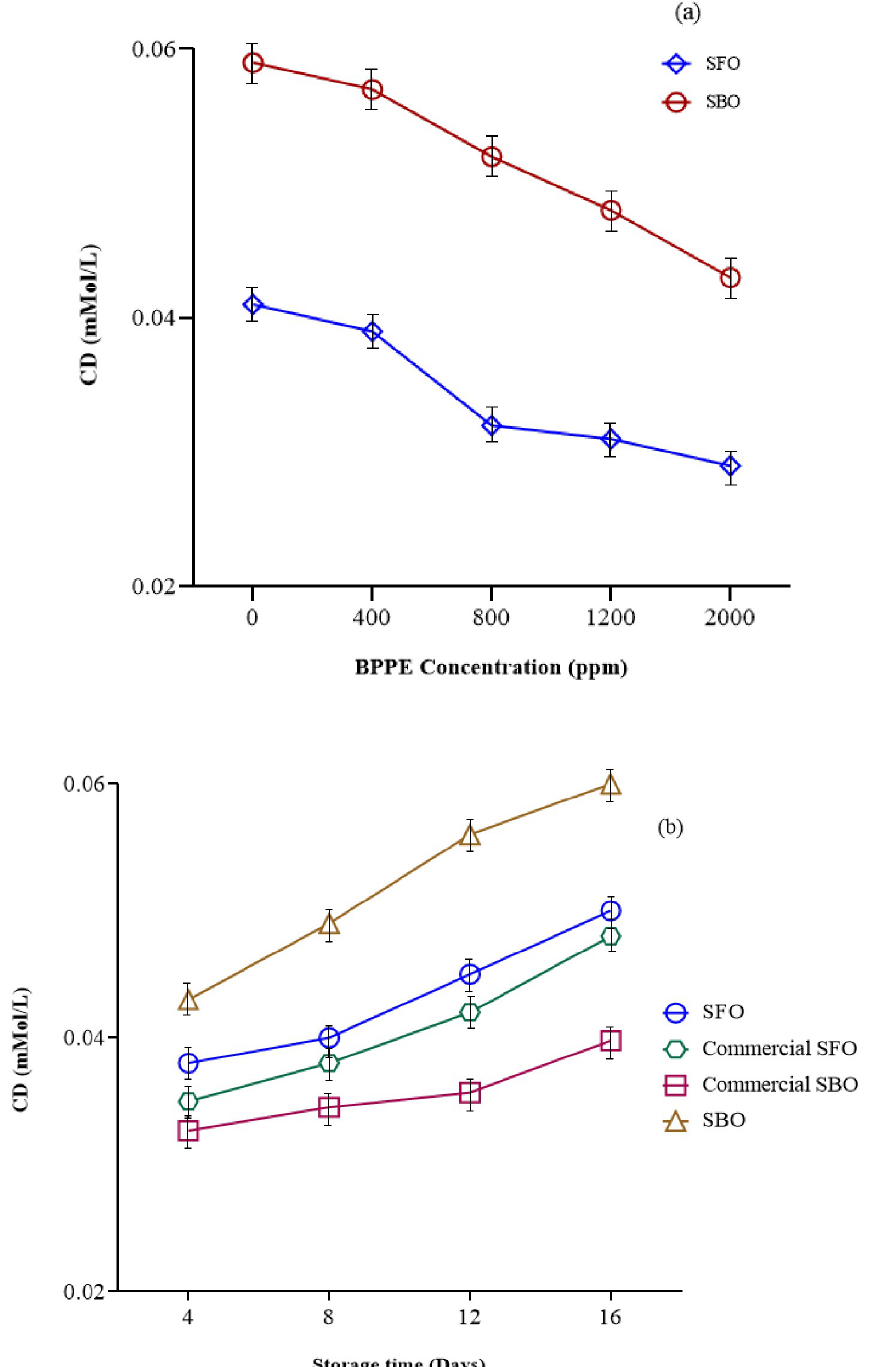
Fig 5. The effect of a) BPPE concentration � and b) storage time � on CD of SBO and SFO. (BPPE: Black plum peel extract, Soy: Soybean oil, Sun: Sunflower oil, CSoy: Commercial soybean oil, CSun: Commercial sunflower oil) � (P �